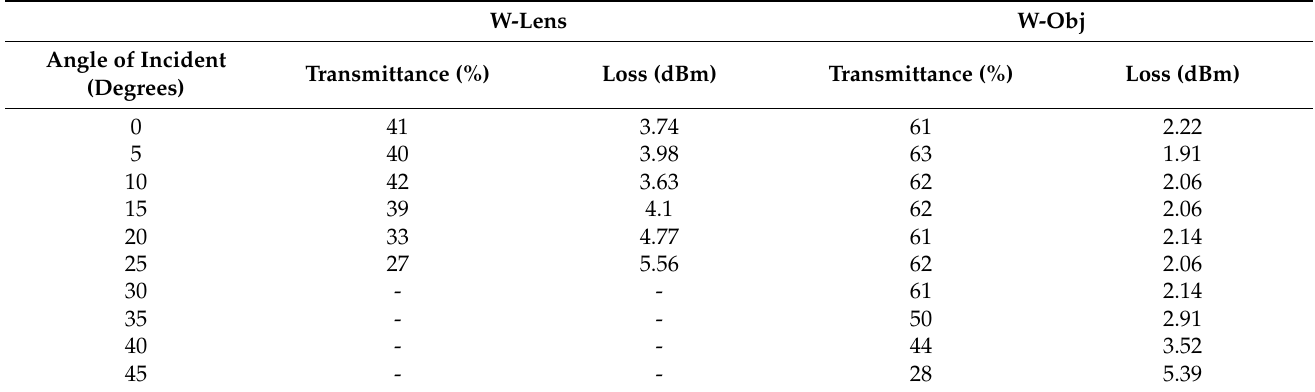
Table 2. Optical losses of W-lens and W-Obj fabricated waveguides.